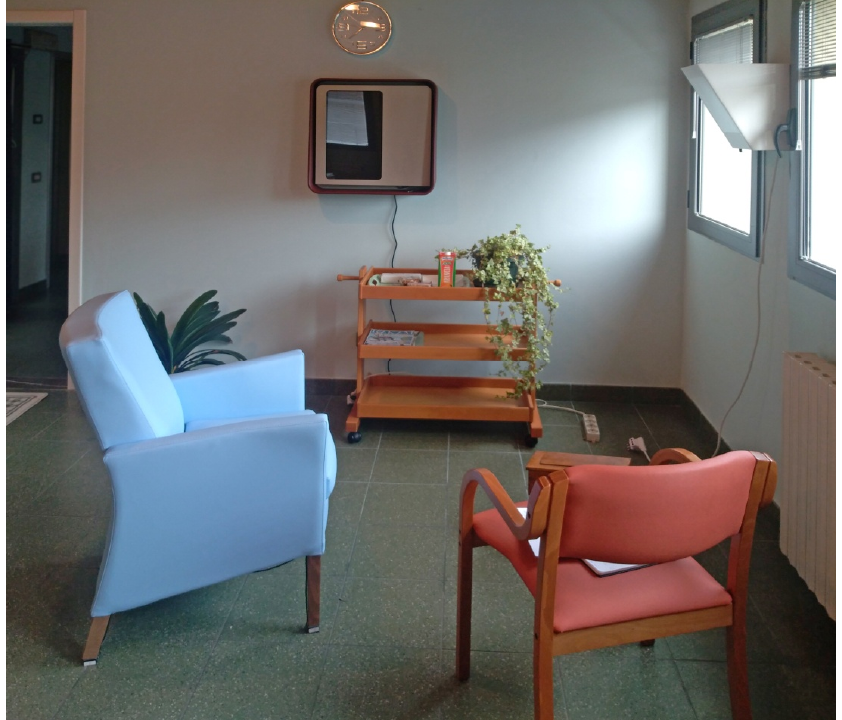
Figure 13. Image of the simulated environment of HABITAT that was disposed for the usability tests (Bologna, Italy, 7th February 2018).